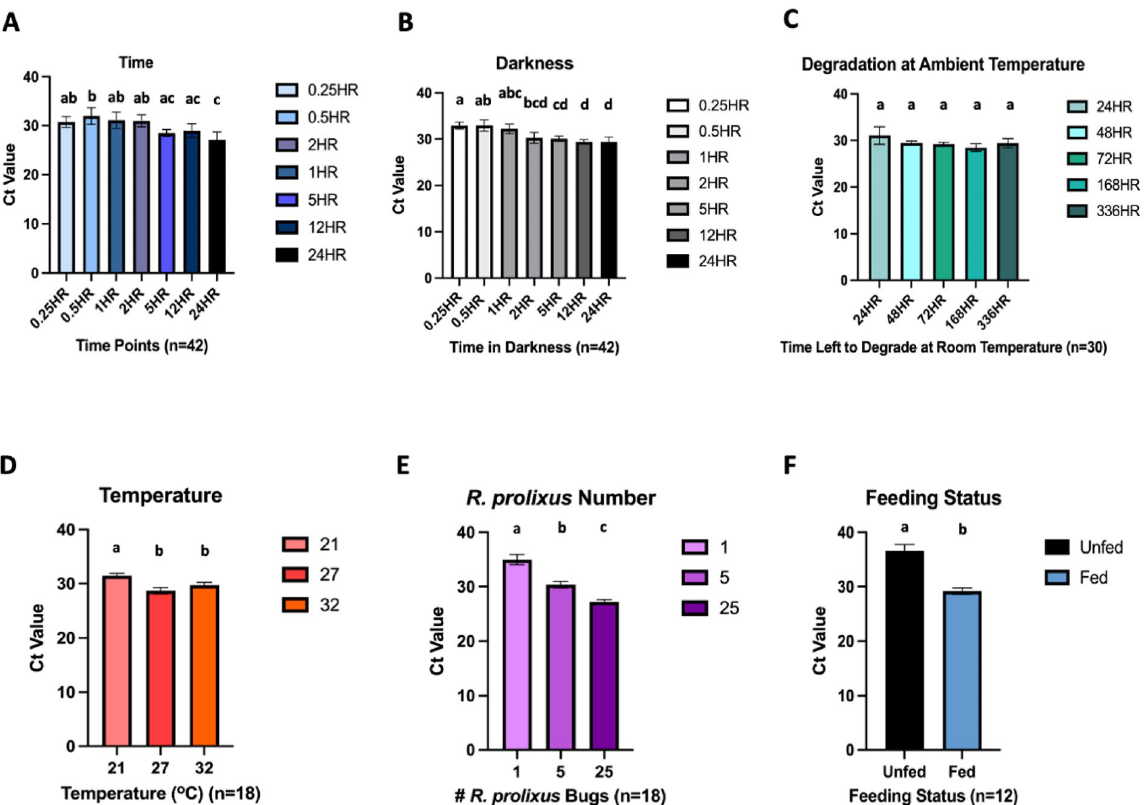
Figure 3. Detection of R. prolixus eDNA from FTA cards under different environmental conditions. ( A ) Time; ( B ) darkness; ( C ) degradation at ambient temperature; ( D ) temperature; ( E ) R. prolixus number; ( F ) feeding status. N = number of separate DNA extractions performed. qPCR detection for all extractions were run in technical triplicate. Conditions sharing a superscript do not differ significantly (Dunn’s multiple comparisons test, p > 0.05). Error bars indicate 95% confidence intervals